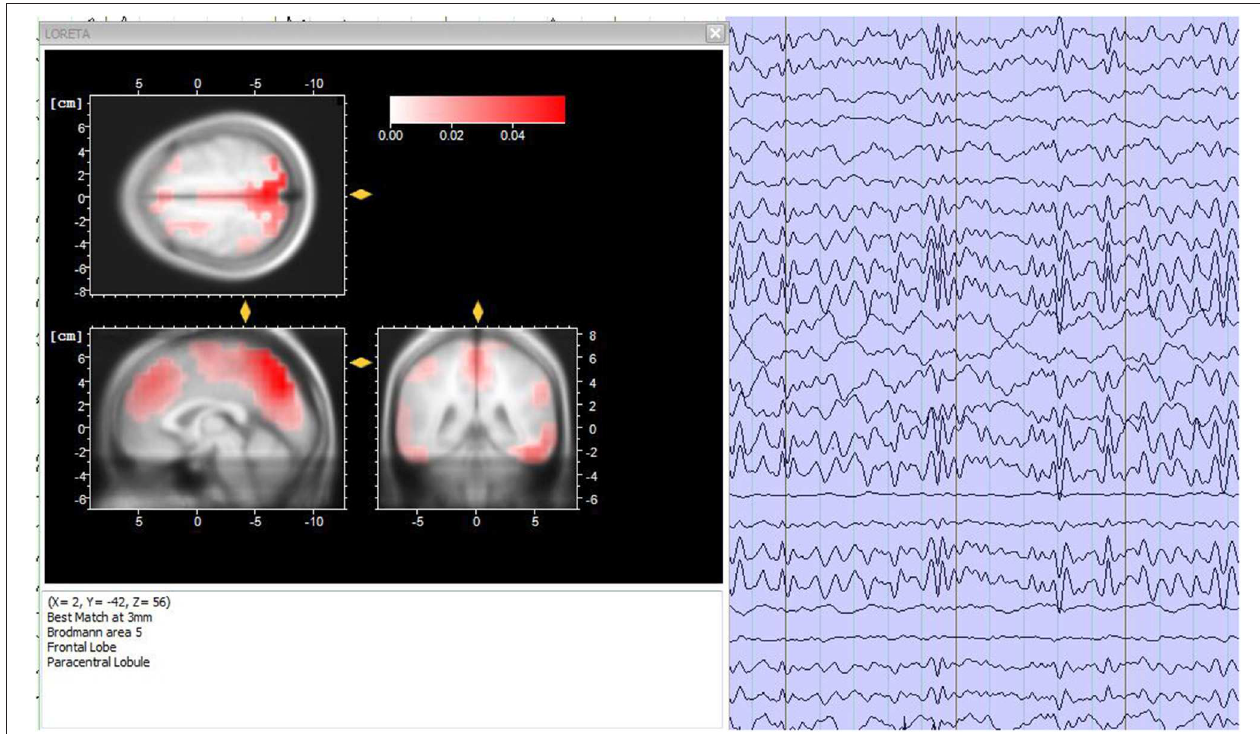
FIGURE 5 | Source analysis. (Left) Sources localization of the EEG frequencies for a time period of 3s, accomplished through the LORETA analysis. (Right) 3-s period electroencephalographic pattern of a healthy subject. Image obtained on a 40 years-old healthy volunteer with hybrid EEG-fMRI system and included for illustrative purpose